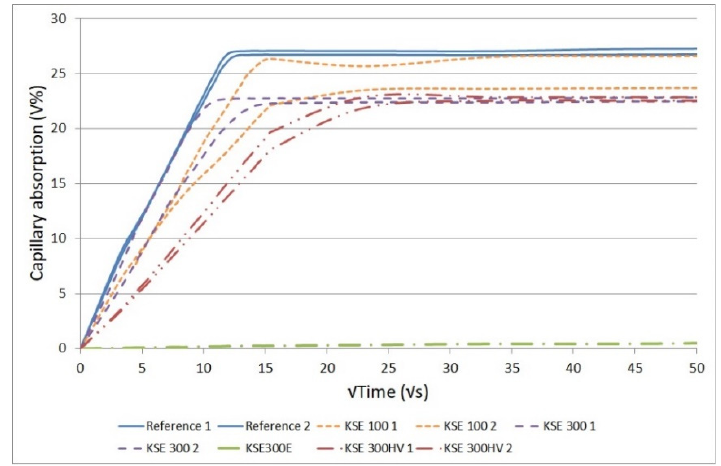
Figure 5. Capillary water absorption in untreated and consolidated fine-grained limestone from Sóskút (SF).